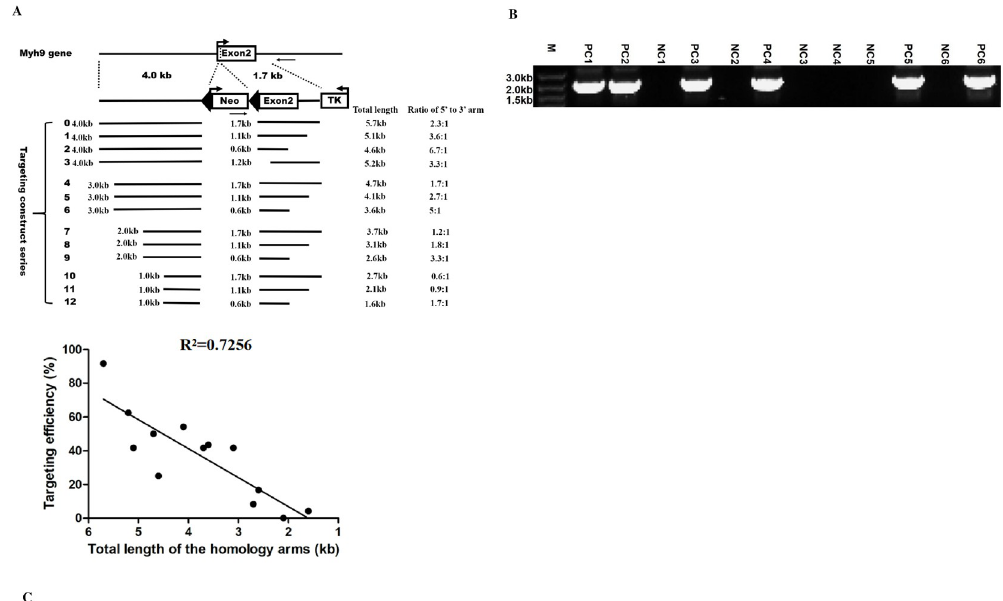
Fig 2. Gene targeting at the Myh9 gene exon2 site with various length of the homologous arms. (A) Diagram of a series of truncated targeting constructs. The 5’ homologous arm is left-side truncated from 4, 3, 2 to 1 kb, while the 3’ one is right- side truncated from 1.7, 1.1 to 0.6 kb. Additionally, a left-side truncated 3’ arm with the deletion of the exon2 and beyond (about 0.5 kb) is also generated. Each targeting construct is given a number (No) as indicated at the left, the total length, the length of each 5’ or 3’ arm and the ratio between them are also indicated. Detailed information of these constructs and their HR frequency in mouse ES cells are summarized in Table 5. The average percentage of HR efficiency is derived from two repeats. (B) Shown is representative gel image of PCR identification of the GT recombinants for the targeting construct No4. M: DNA marker; PC: positive clone; NC: negative clone. (C) The graph indicates a downward trend of the gene targeting efficiency with the decreased length of the homologous arms and reflects the correlation of the gene targeting frequency with the total length of the homologous arms, the R 2 value shown in the graph is calculated from thirteen points (p < 0.01). https://doi.org/10.1371/journal.pone.0230126.g002 provided some new insight into homologous recombination-based gene targeting. Firstly, through the analysis of the Myh9 and several other widely used loci for targeting transgenesis, the properties of a 6 kb total length, and 50% GC-content present in the homologous arms,